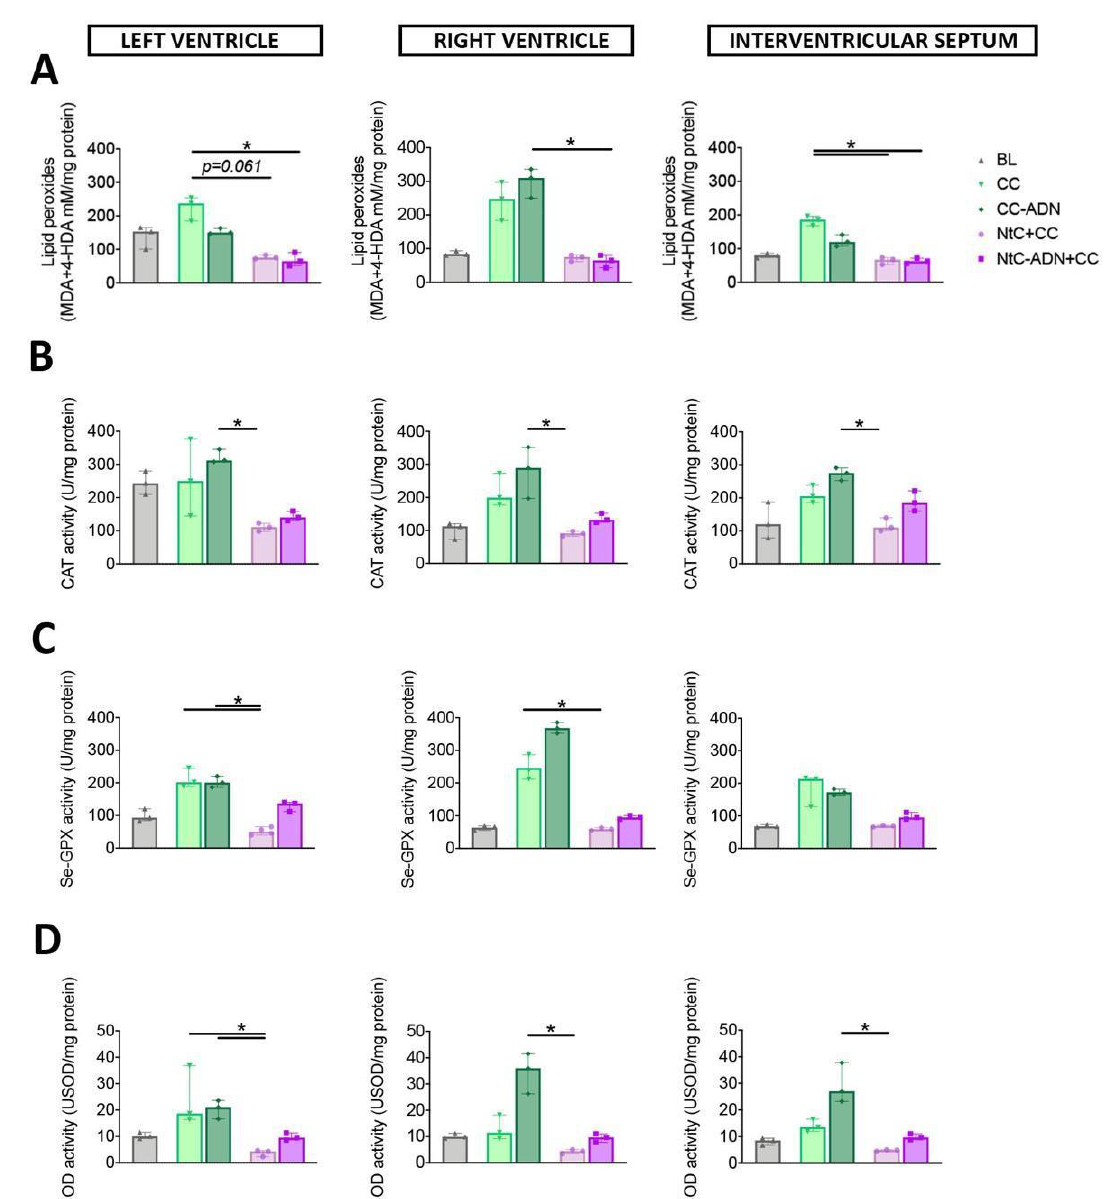
Figure 1. NtC + CC treatment prevents heart ventricle tissue from oxidative damage. Myocardial oxidative stress was quantified as ( A ) Myocardial lipid peroxidation; ( B ) Myocardial catalase activ- ity; ( C ) Myocardial selenium-dependent glutathione peroxidase activity; ( D ) Myocardial SOD cyto- solic activity. Values are shown as median ± range, n = 3. Note * p < 0.05. BL: baseline; CC: cardio- plegia; CC-ADN: cardioplegia supplemented with adenosine; NtC + CC: 250 mL warm cardioplegia + 750 mL cold cardioplegia; NtC-ADN + CC: 250 mL warm cardioplegia supplemented with aden- osine + 750 mL cold cardioplegia.